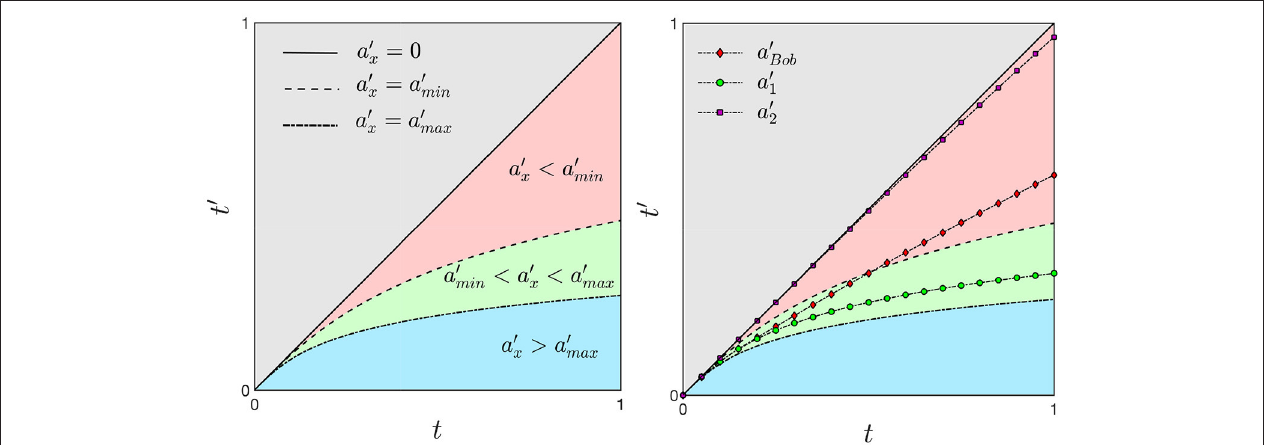
FIGURE 5 | On the left) For an accelerating frame of reference a time interval 1 t = 1 corresponds to shorter 1 t ′ with an consequent dilation of time. The green region represents a distribution of accelerations associated with an average range of accelerations that is used as a common reference for accelerated and decelerated processes. Smaller values of the acceleration are related to time contraction (pink region, a ′ x < a ′ min ) while large values are associated with time dilation (blue region, a ′ x > a ′ max ). On the right) In the mental illustration of the lifetime of Bob, a deceleration will bend Bob’s trajectory (black line with red diamonds markers) out of the green region with a corresponding contraction of